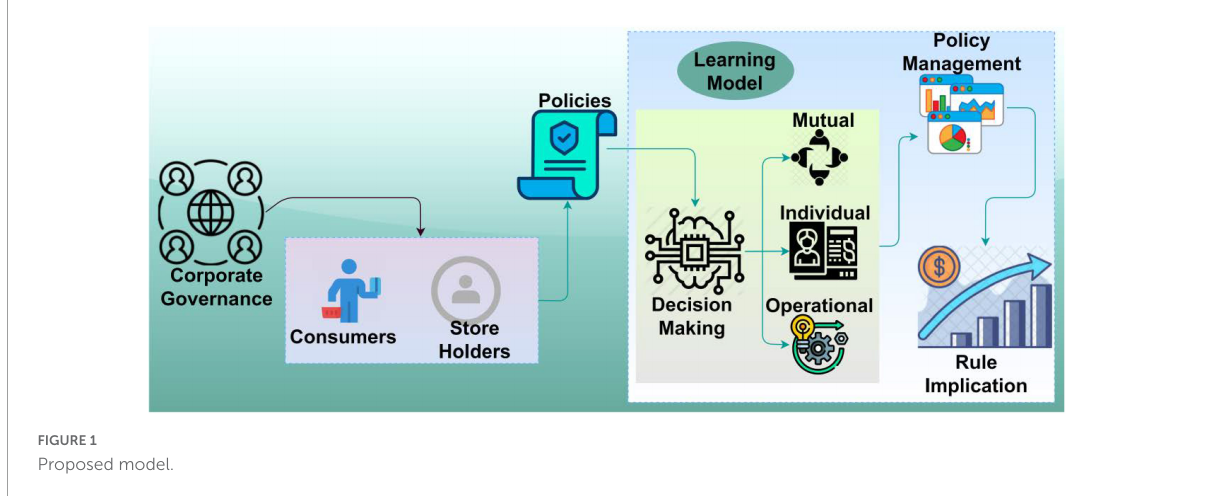
FIGURE1 Proposed